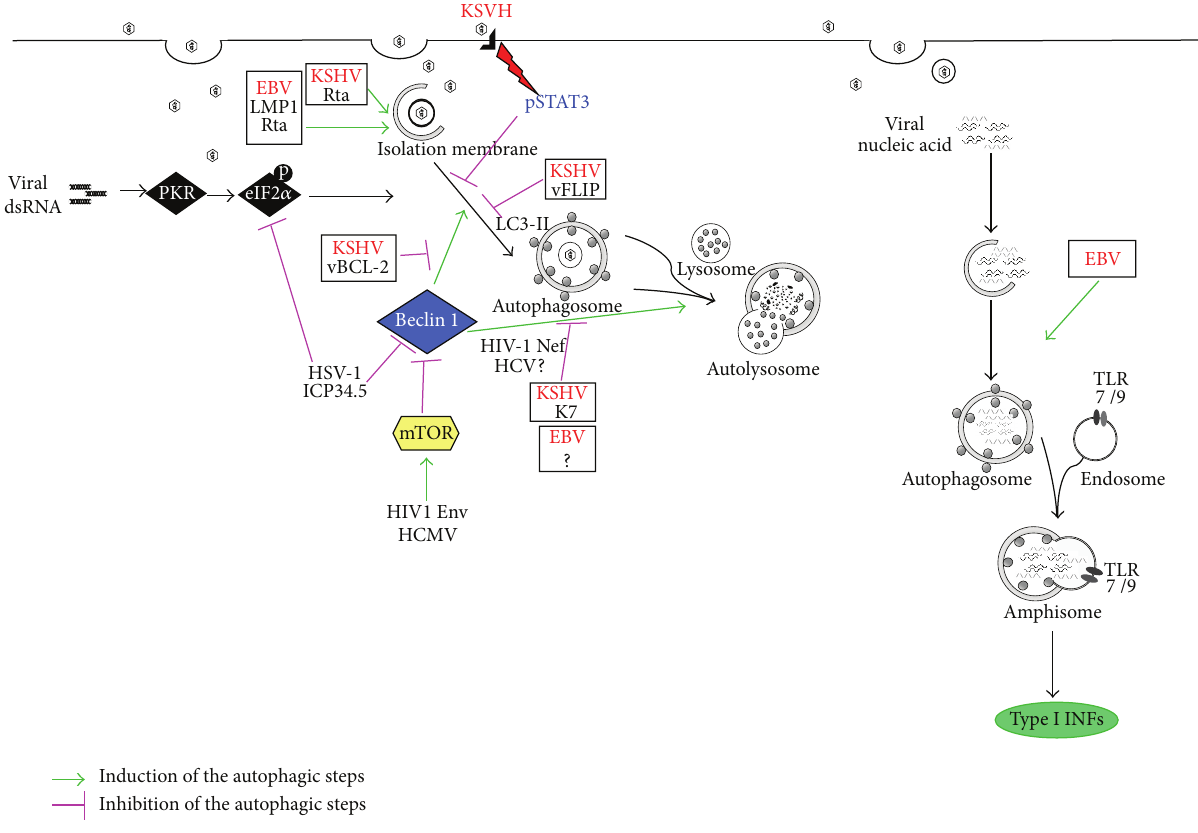
Figure 1: Examples of autophagy manipulation by human